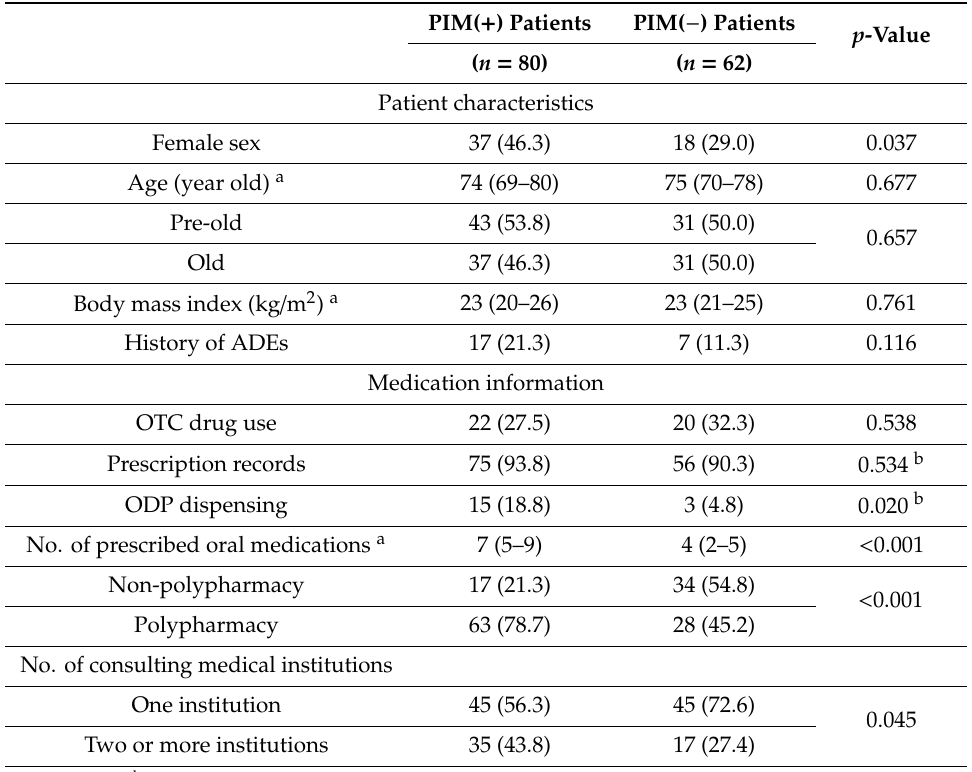
Table 4. Association of PIM use with patient characteristics and medication information ( n = 142). PIM( + ) Patients PIM( − )